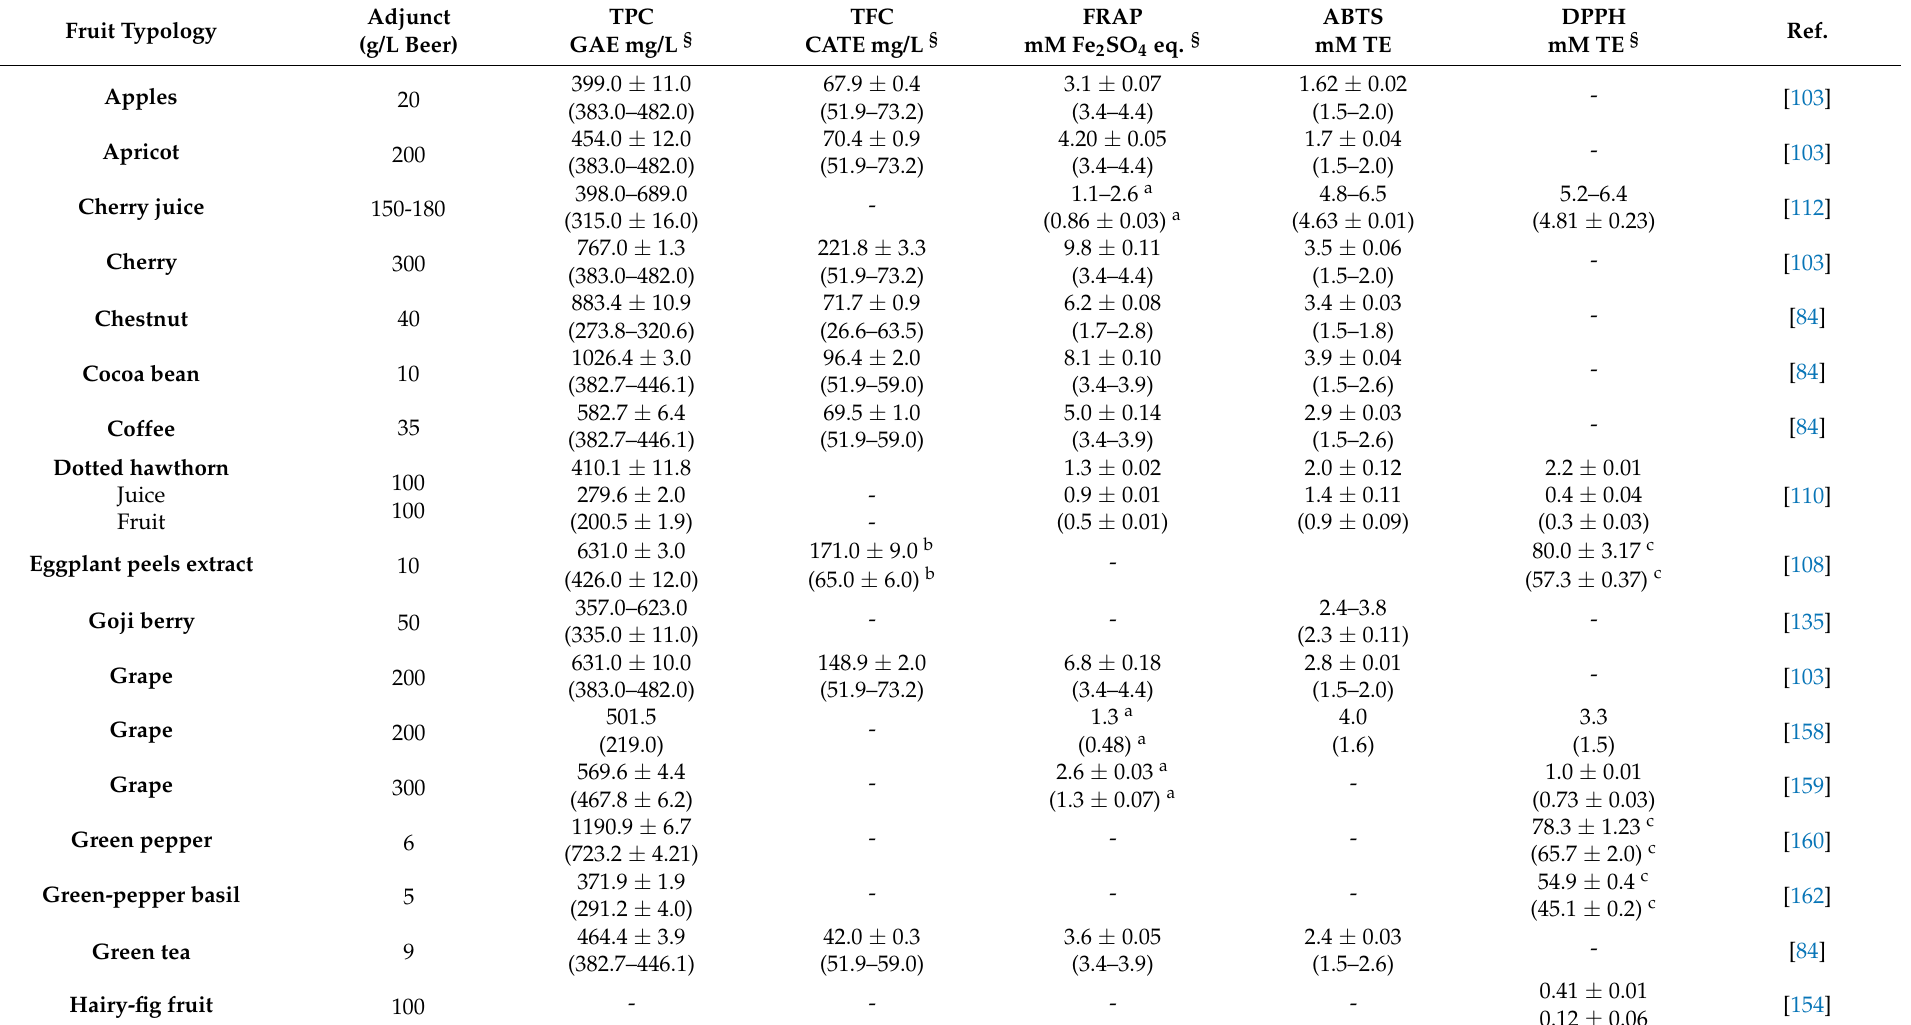
Table 3. Antioxidant activity, and total polyphenol and flavonoid contents of beers with added fruits, vegetables, herbs, and natural